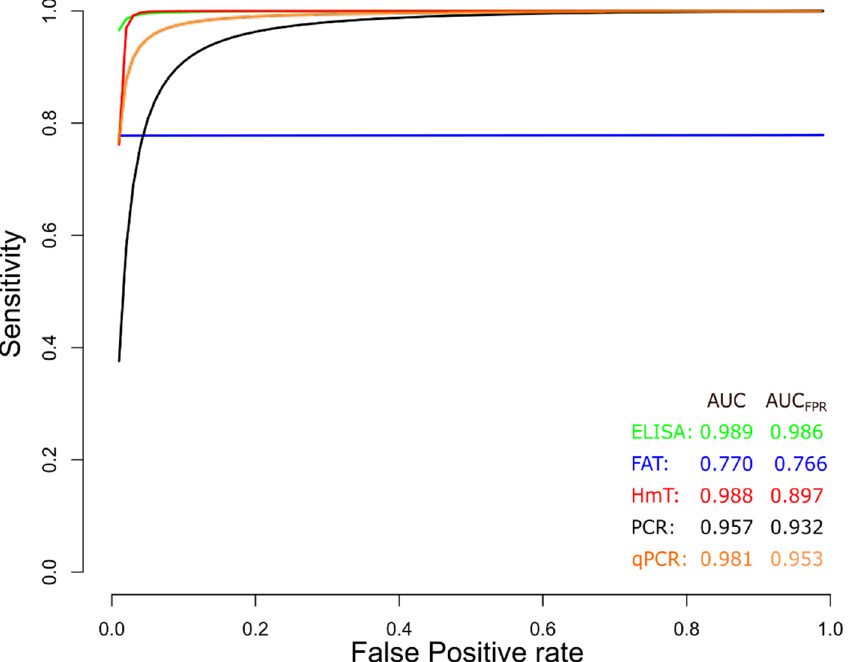
Figure 9. Meta-analysis of diagnostic test accuracy analysis. Summary receiver operating curve (sROC) plot of false positive rate and sensitivity. Comparison between ELISA, IFAT, HmT, PCR, and qPCR methods in the diagnosis of chronic Chagas disease .